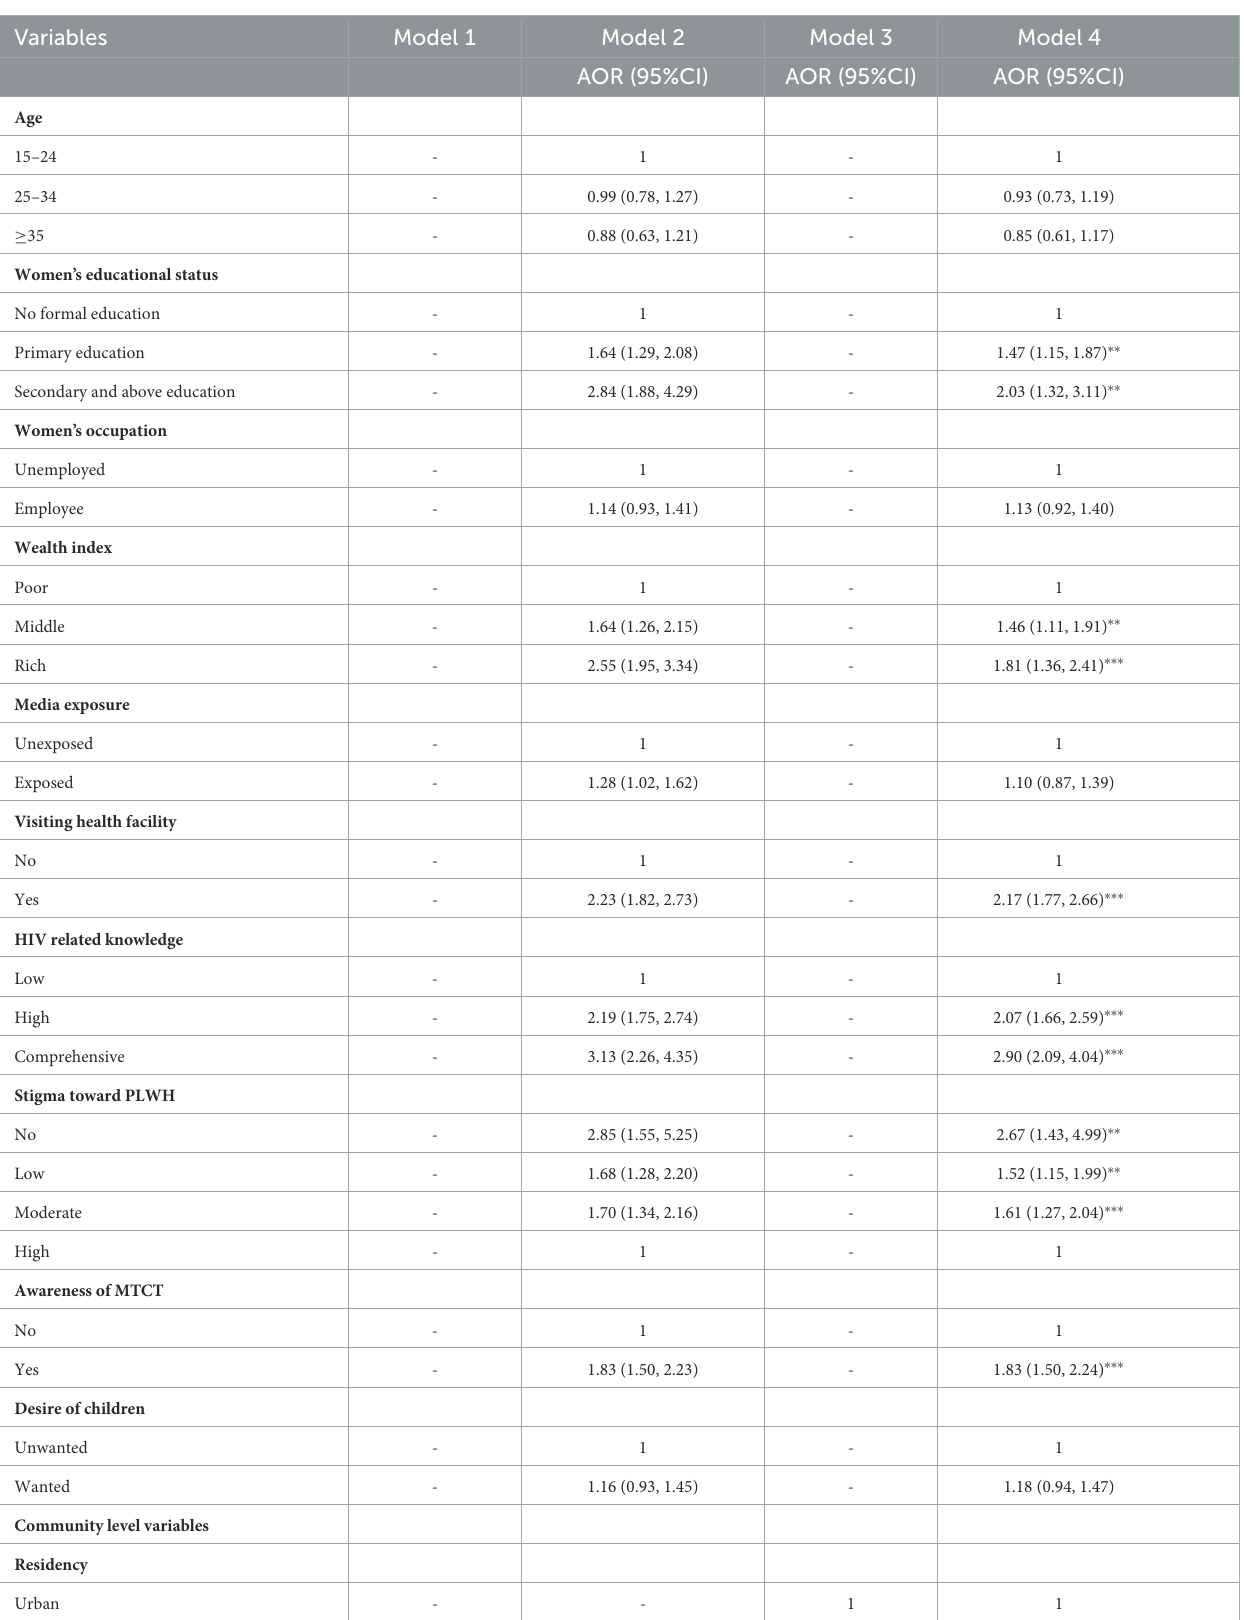
TABLE 3 Multivariable multilevel logistic regression analysis of individual- and community-level determinants of prenatal HIV test uptake in Ethiopia based on the 2016